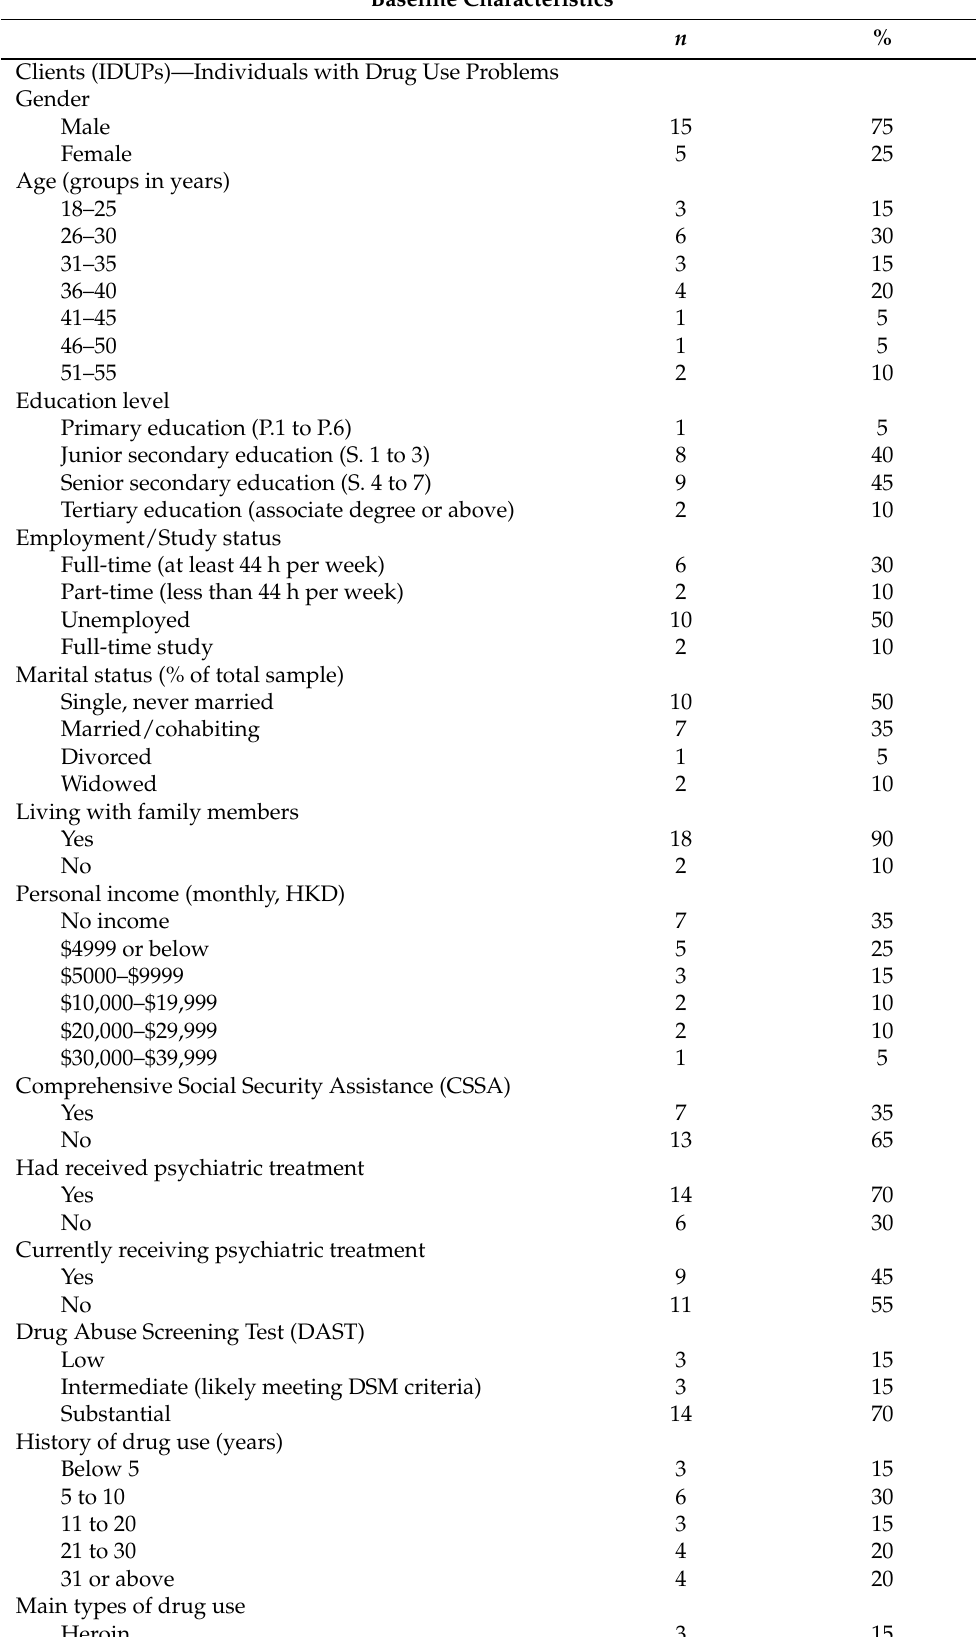
Table 1. Sociodemographic characteristics and drug use background of participants at